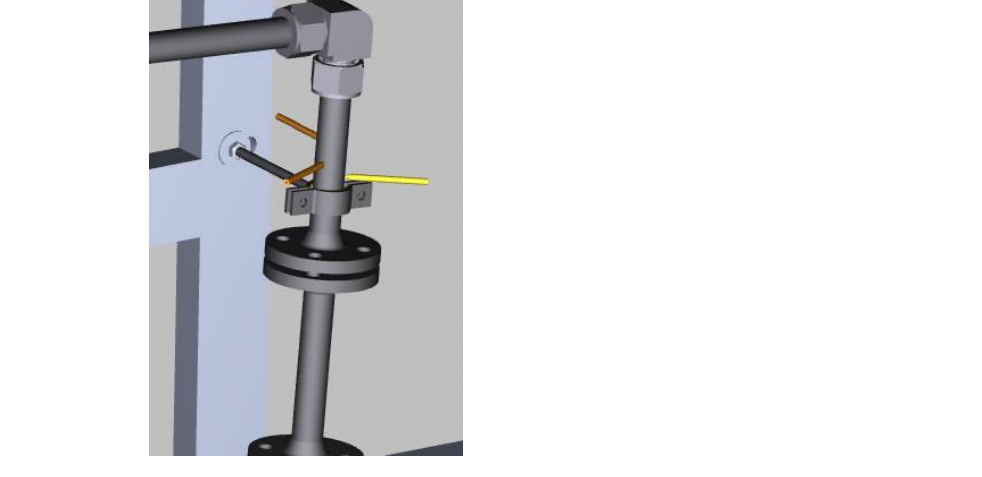
Figure 5. Fluid temperature measurement system through three-point finger system.